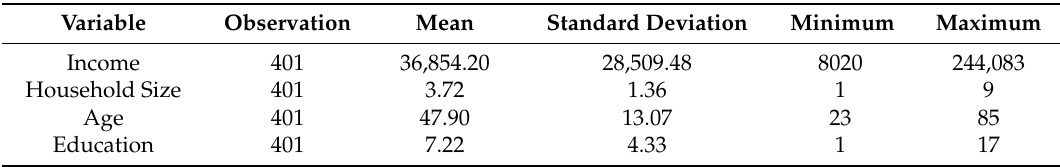
Table 3. Summary of continuous variables.